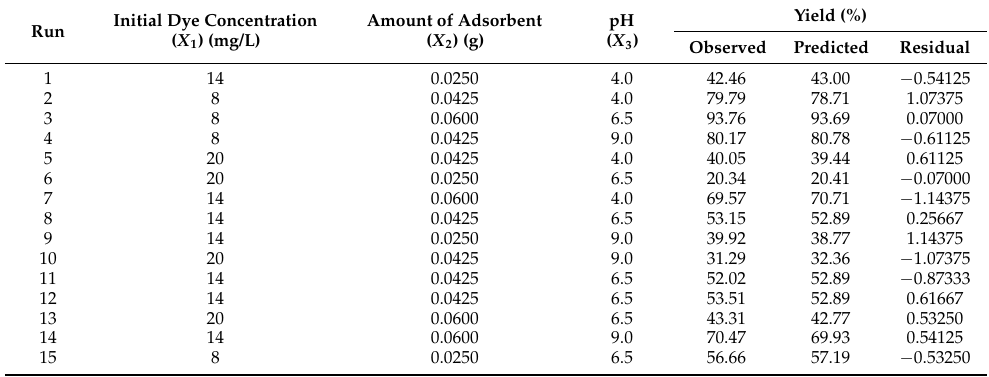
Table 4. The uncoded Box–Behnken design matrix of experiments for MB removal.